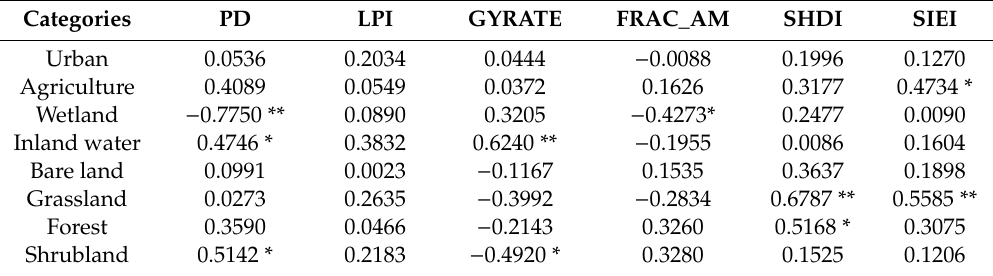
Table 3. Spearman’s correlation coe ffi cients between landscape composition and structure metrics. ** and * denote significant correlation at the 0.01 and 0.05 level,